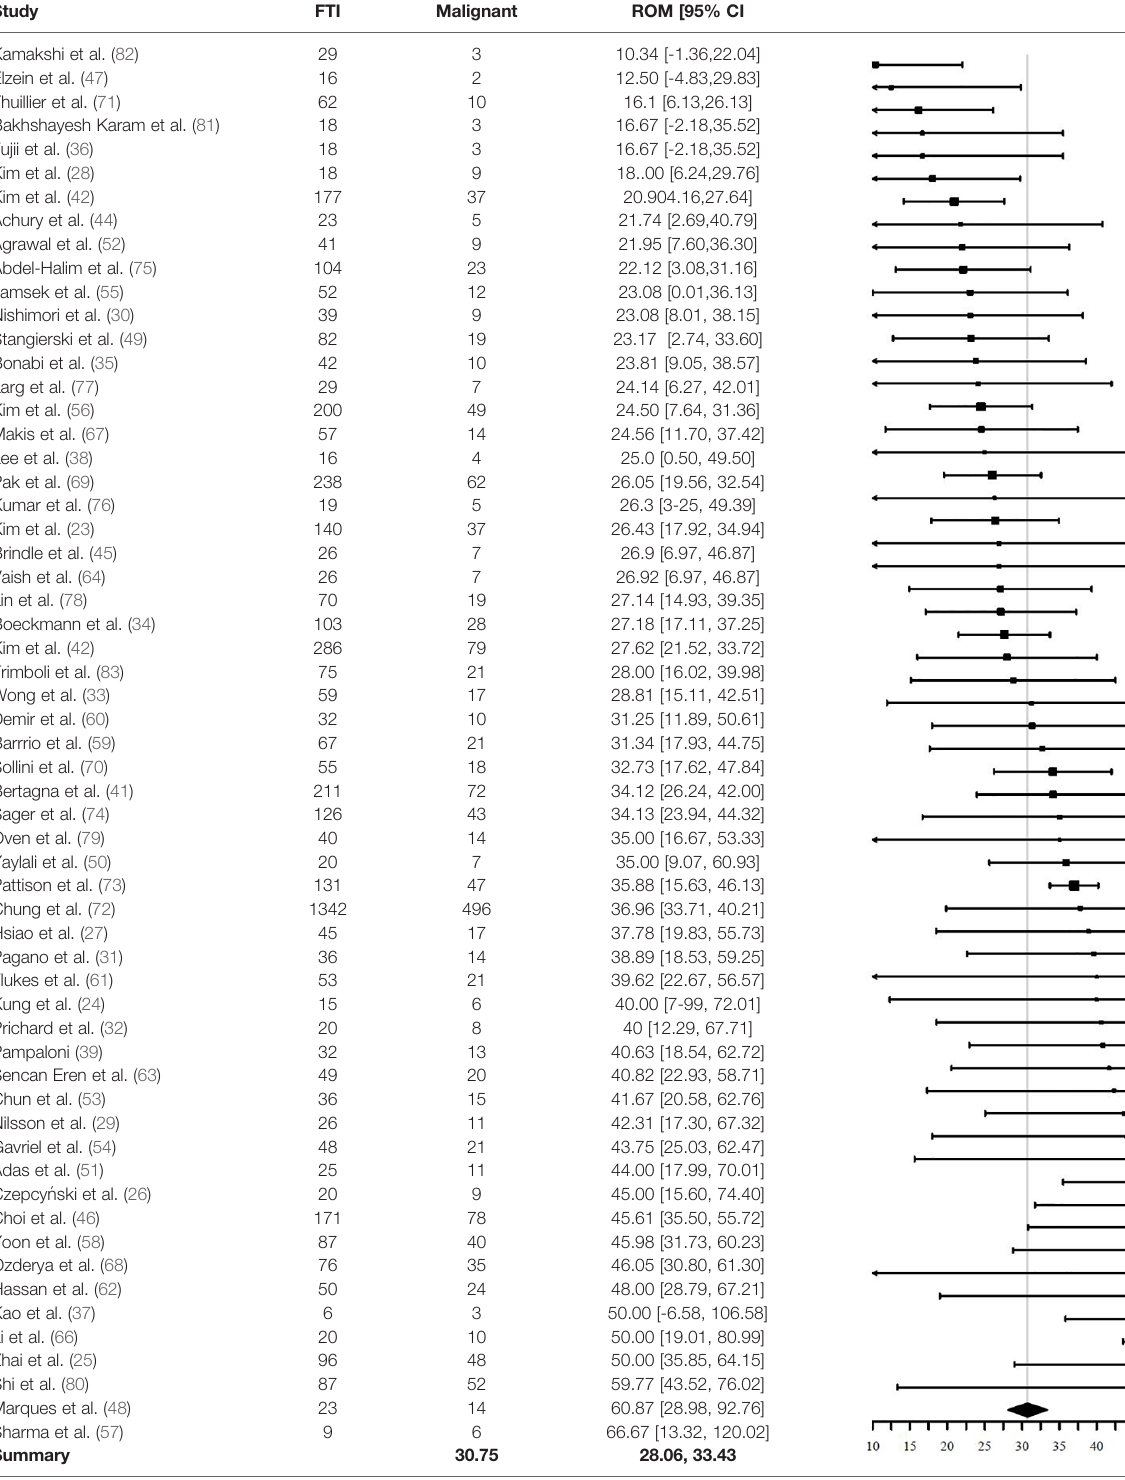
TABLE 4 | Risk of malignancy of FTI (random effects, I 2 = 57%, symbol size re fl ects weight). Study FTI Malignant ROM [95% CI Kamakshi et al.